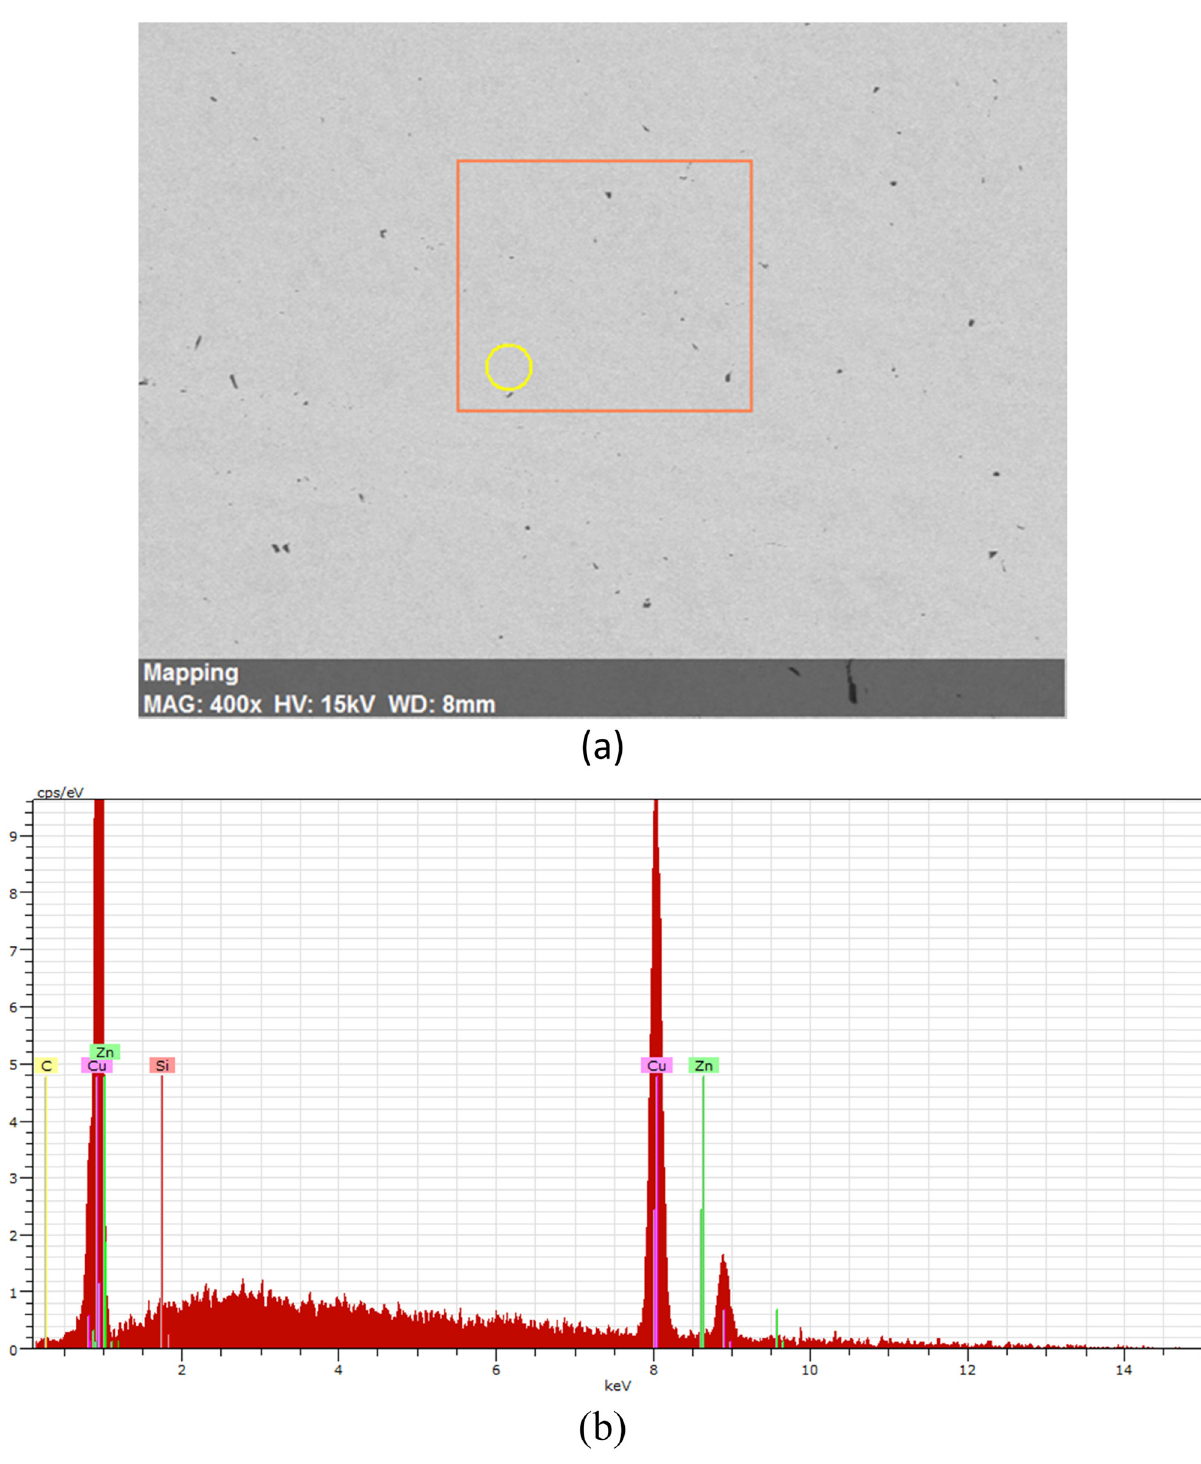
Figure 1: ( a ) SEM micrographs and ( b ) EDS analysis of the AR Cu billets ( the orange frame shows the elemental mapping area and the yellow circle shows the area of the EDS analysis ) volume ratio of 3:1 as a fi nal preparation step. The che - mical composition analysis of the Cu billets was con - ducted using EDS.